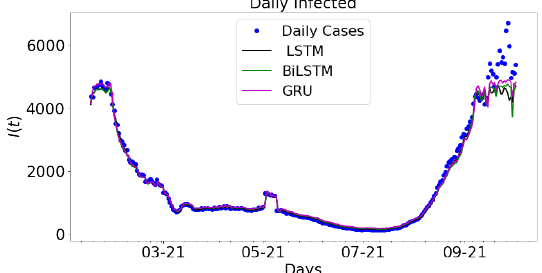
Figure 13. Data-driven simulation for LSTM, BiLSTM, and GRU.